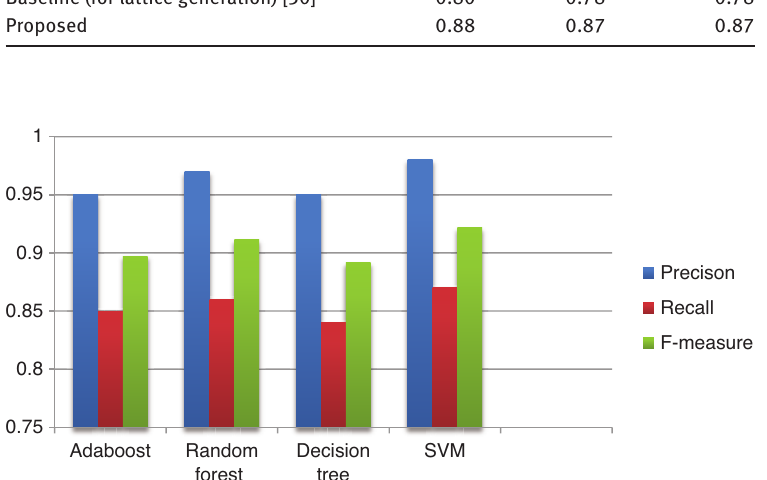
Table 4: Precision, Recall, and F1 Score Comparison of Baselines and Our Proposed Method for Concept Lattice Generation. Algorithm